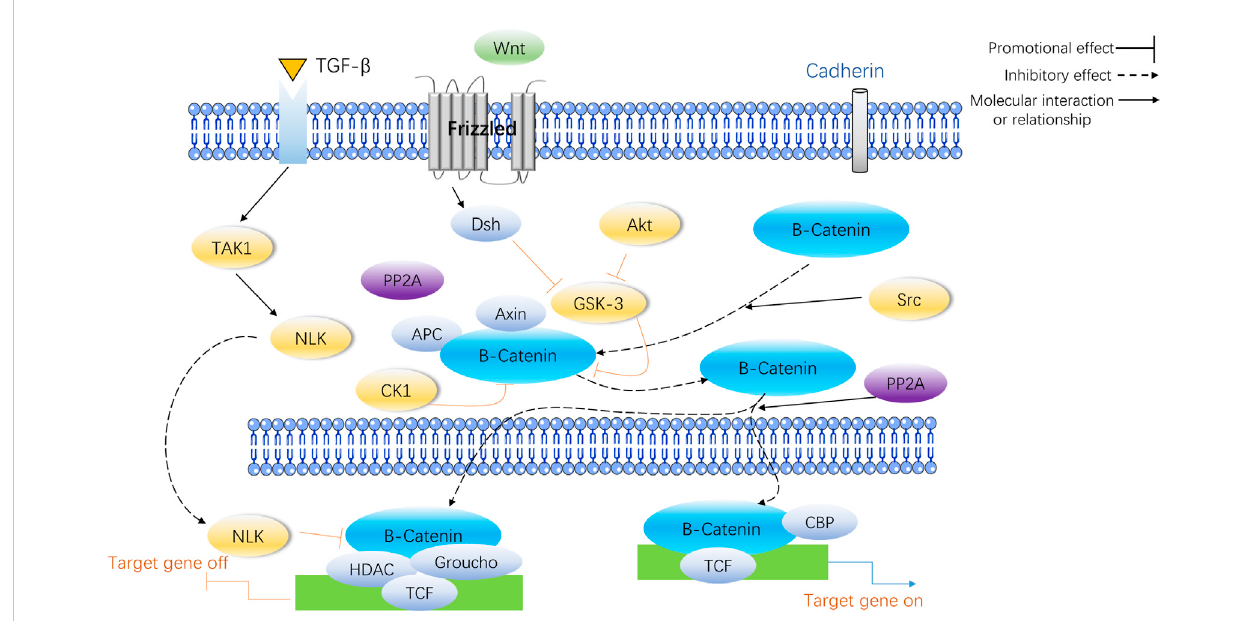
FIGURE 2 miRNA, lncRNA and circRNA affect bone metabolism and participate in the occurrence and development of